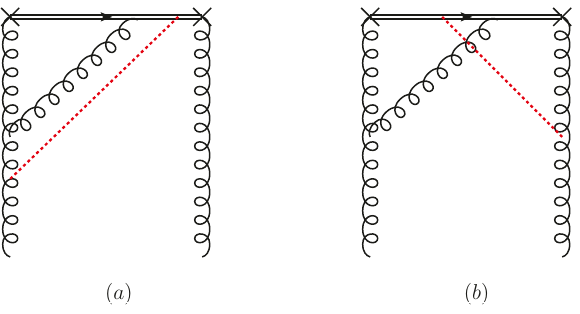
Figure 9 . Typical two-loops corrections to quasi gluon distribution, in which only one endpoint of the added internal gluon line is connected to the Wilson line.